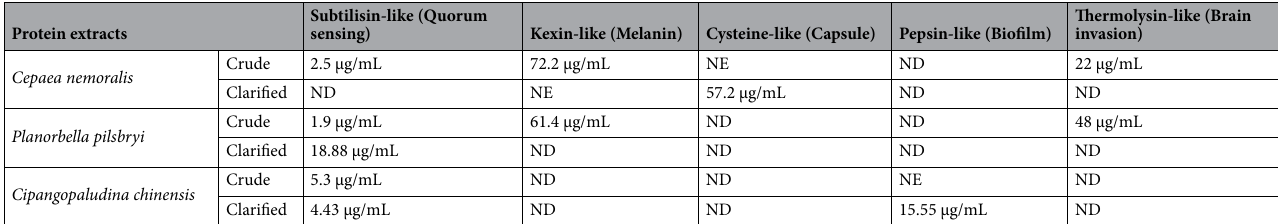
Table 2. IC 50 values of mollusk extracts towards virulence-related peptidases defined in Cryptococcus neoformans . ND not determined, NE no effect.